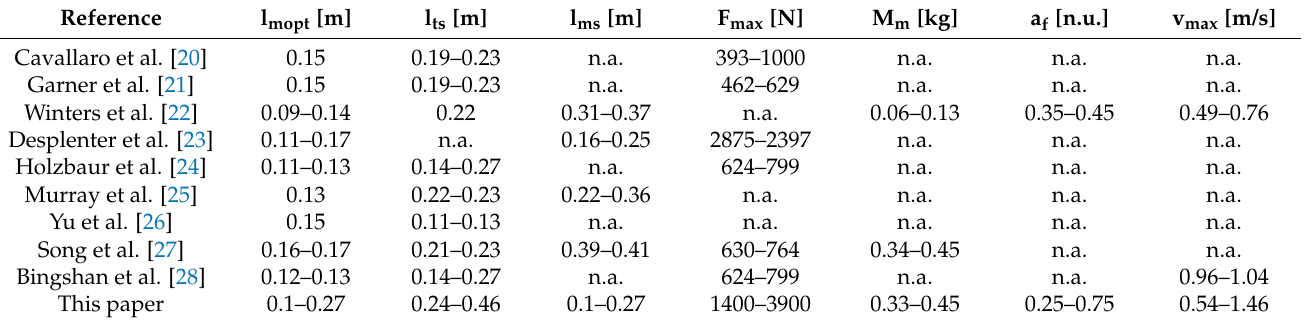
Table 5. Comparative analysis of the Hill’s muscle model and passive joint structure model